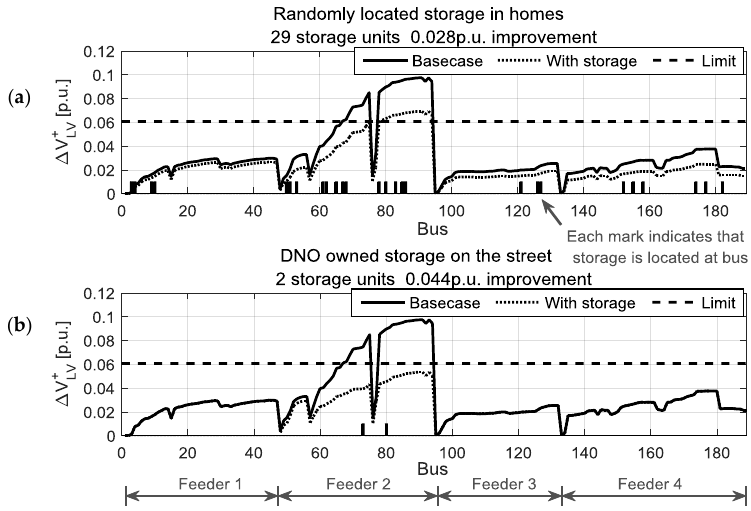
Figure 6. Application of the method to a single LV network. 100% of suitable roofs have PV. ( a ) shows the application of the tool with randomly located single phase storage of rating 3.6 kW and ( b ) shows three phase 25 kW storage which is strategically located by the